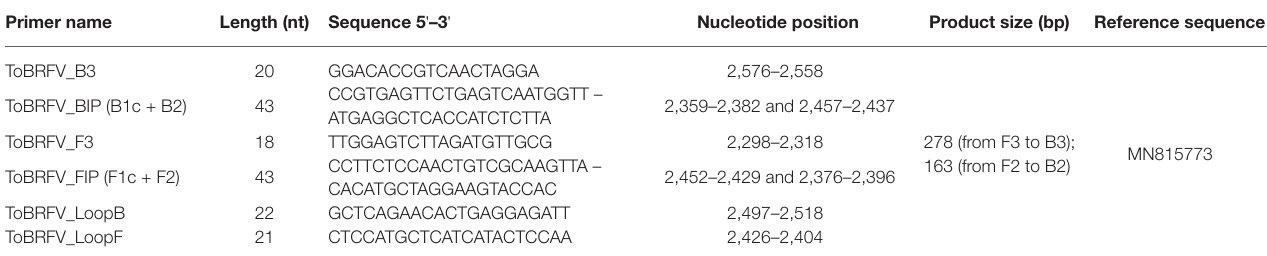
TABLE 1 | RT-LAMP primers for detection of ToBRFV designed in this